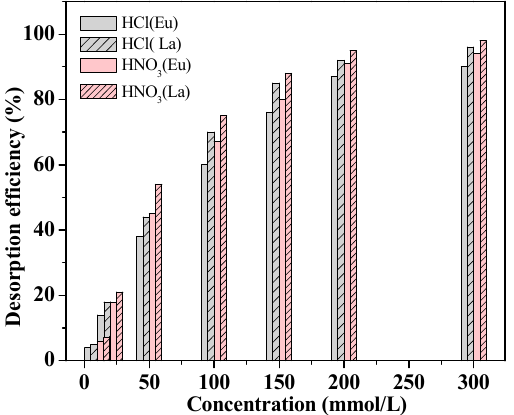
Figure 6. Desorption efficiency of Eu(III) and La(III) ions using HCl or HNO 3 .